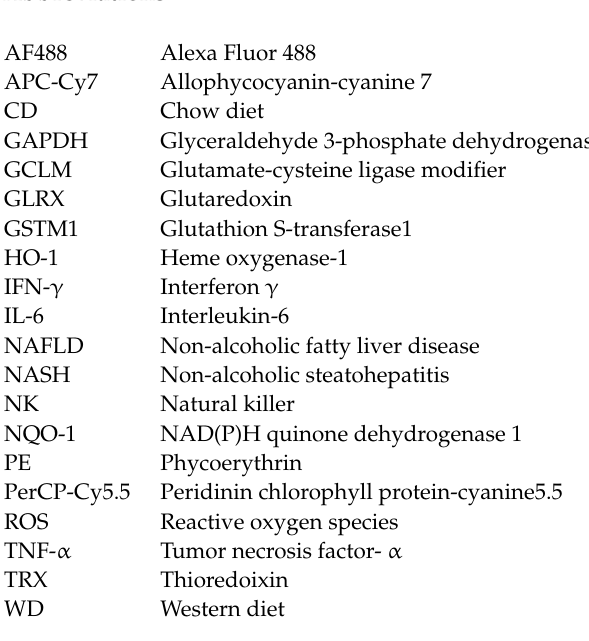
tocytes. Figure S2: Immune cell subset gating by multiparameter flow cytometry. Figure S3: WD- feeding does not cause significant histological gut changes. Figure S4: Rarefaction curves depicting sequencing depth. Figure S5: WD-feeding causes robust shifts in gut microbiota